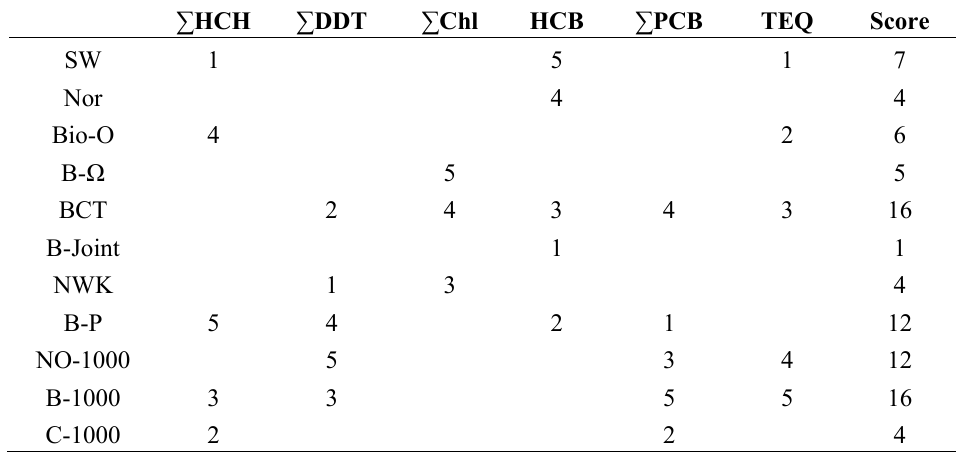
Table 5. Ranking (1–5) of products according to analyte or TEQ category where a score of 5 denotes the highest concentration/index value. ∑ HCH ∑